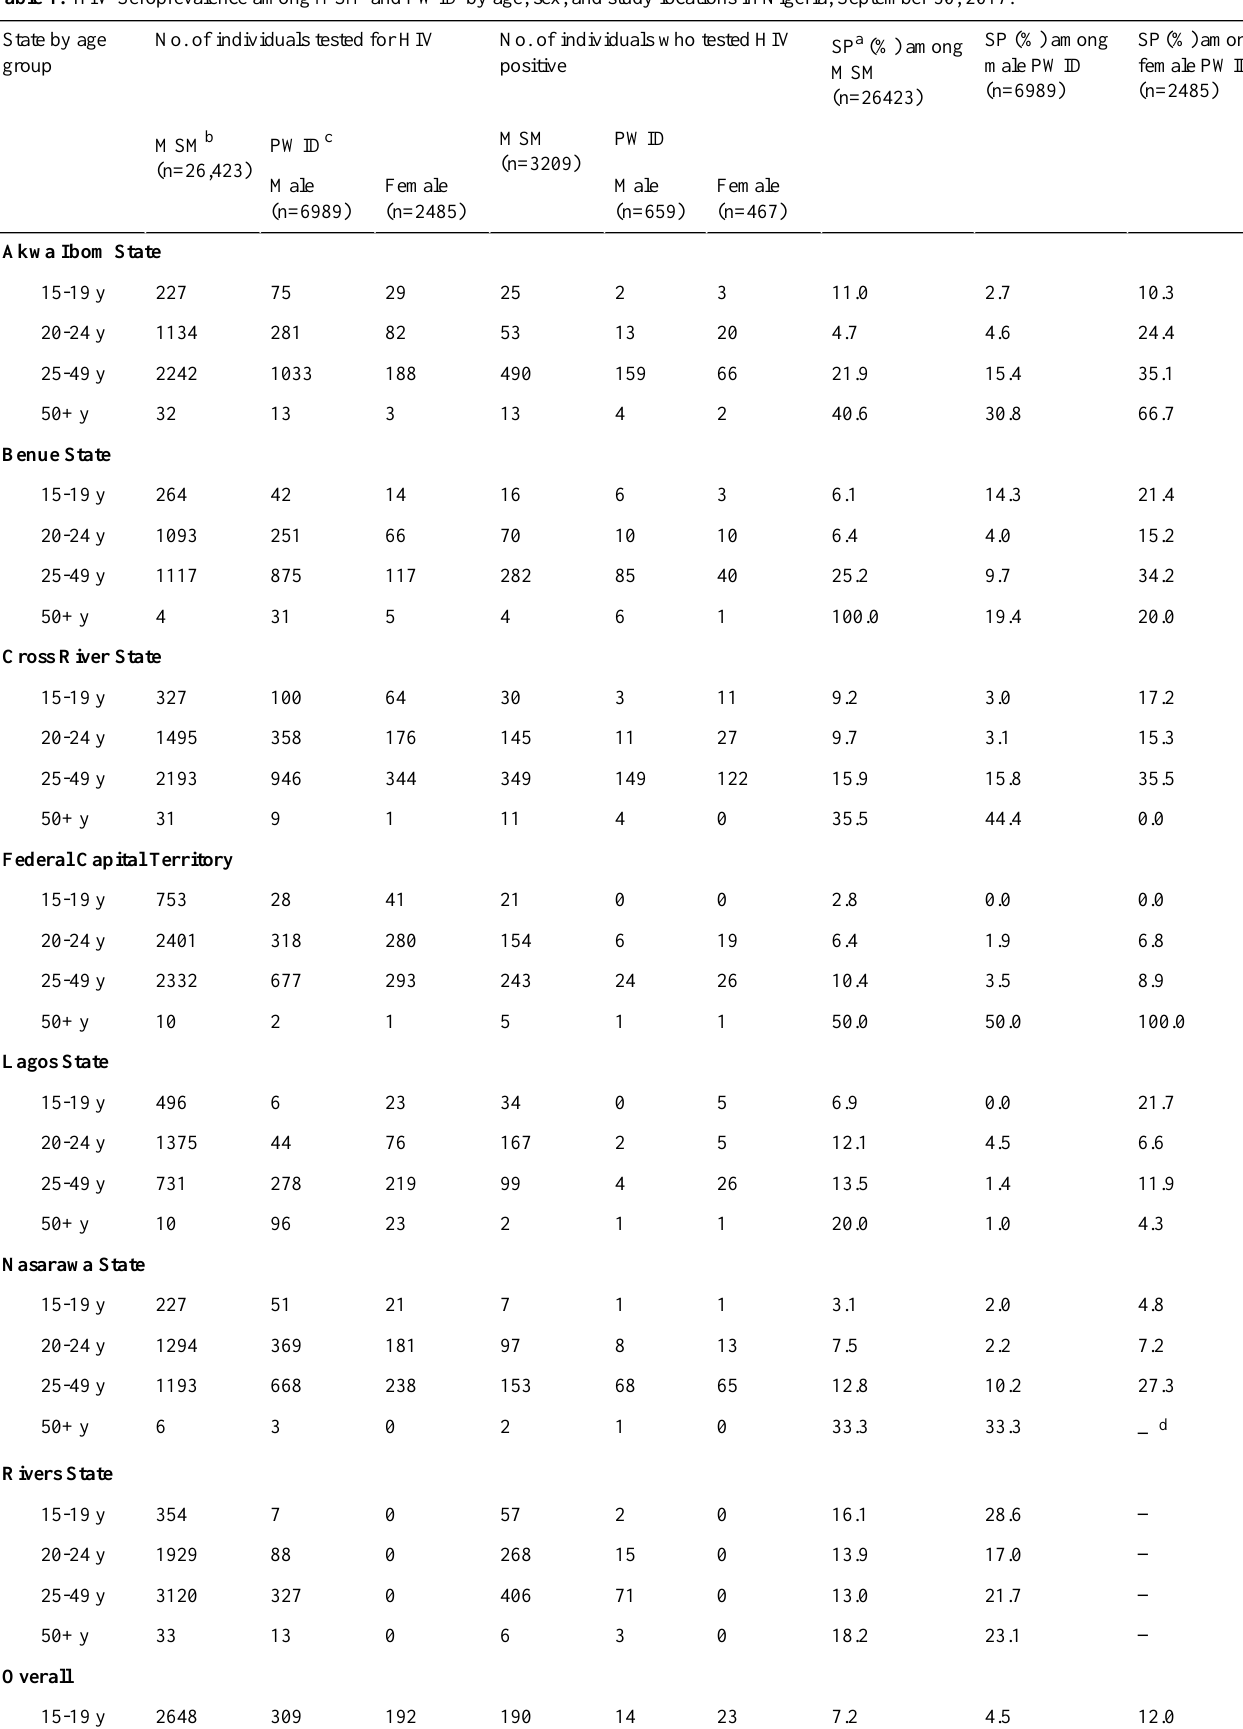
Table 1. HIV Seroprevalence among MSM and PWID by age, sex, and study locations in Nigeria, September 30,